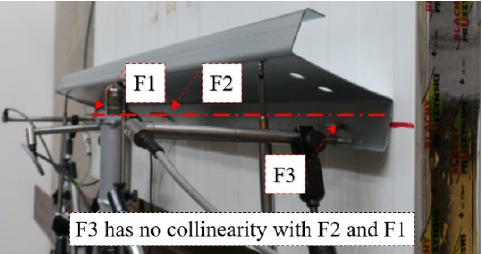
Figure 7. Lack of the collinearity of the self ‐ drilling fasteners (F).